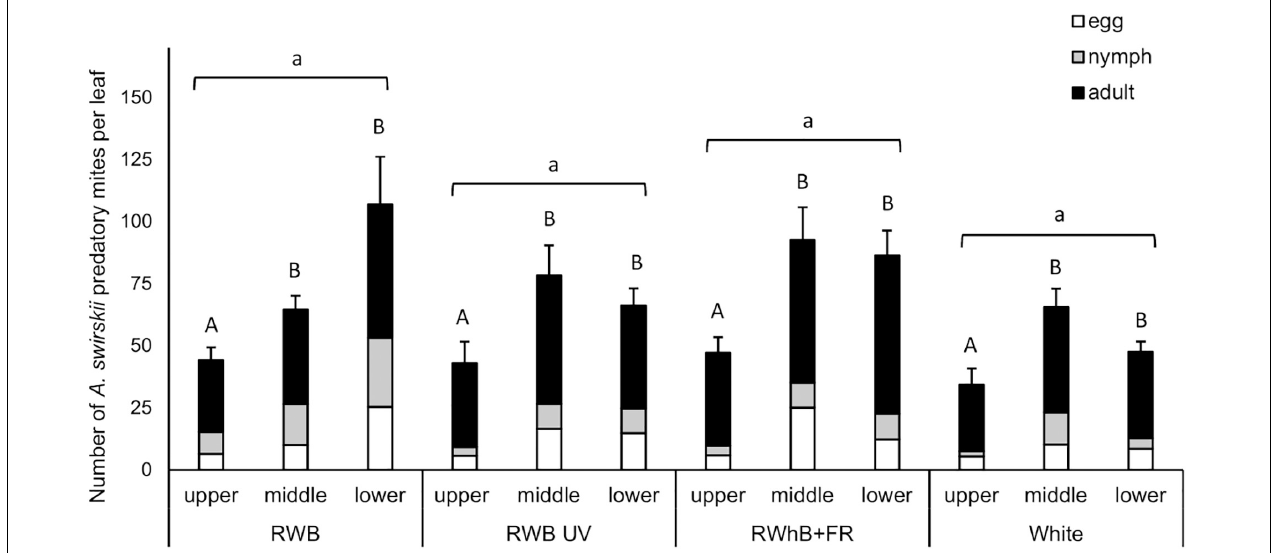
FIGURE 3 | Effect of the light treatments RWB, RWB UV, RWhB + FR, and White on the average number of Amblyseius swirskii individuals per leaf ( ± standard error of the mean), subdivided into average numbers of eggs, nymphs, and adults, in the upper, middle, and lower leaf layers ( n = 2; 12 plants per treatment). Data were analyzed with a generalized linear mixed model with Poisson data distribution where plant replicate nested within table was introduced as a random factor into the model. Different small letters indicate significant differences ( P < 0.05) between light treatments and different capital letters indicate significant differences ( P < 0.05) between leaf layers.